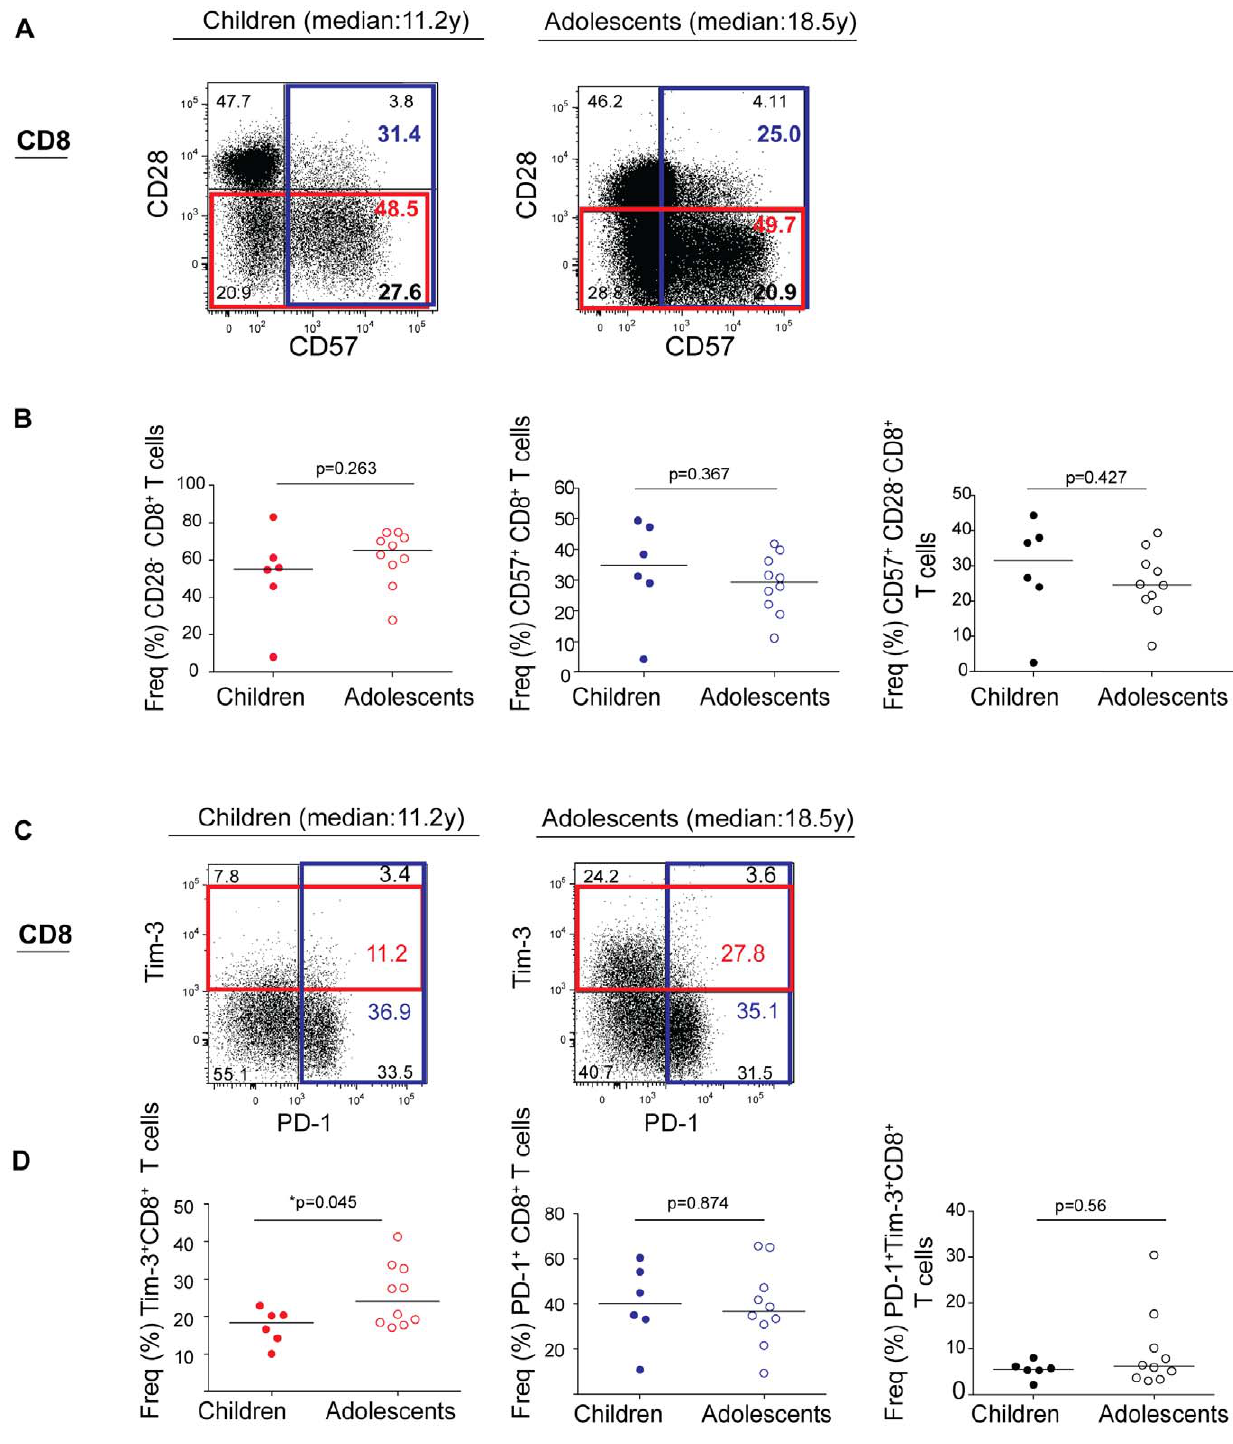
Figure 1. Expansion of Tim-3 + CD8 + T cells in perinatally HIV-1-infected adolescents. (A) Flow dot plots show CD8 + T cell surface expression of CD28 and CD57 in perinatally HIV-1-infected children with shorter duration of HIV-1 infection (median: 11.2 y) and adolescents with longer duration of HIV infection (median:18.5 y). (B) Frequencies of CD28 2 , CD57 + , and CD57 + CD28 2 CD8 + T cells in perinatally HIV-1-infected children and adolescents. (C) Flow dot plots show CD8 + T cell surface expression of PD-1 and Tim-3 in perinatally HIV-1-infected children with shorter duration of HIV infection (median: 11.2 y) and adolescents with longer duration of HIV-1 infection (median: 18.5 y). (D) Frequencies of Tim-3 + , PD-1 + , and PD-1 + Tim-3 + CD8 + T cells in perinatally HIV-1-infected children and adolescents. A significant increase in Tim-3 + CD8 + T cell (*p=0.045) population was observed with age. P values were obtained using two-tailed Mann-Whitney U test. Flow dot plots are representative of all subjects in respective groups.